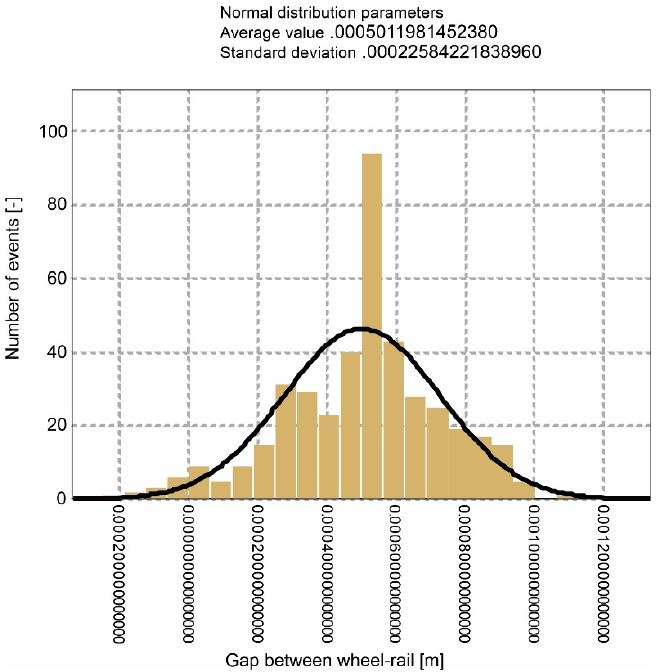
Figure 9. Normal distribution for a wheel–rail gap in the rail turnout.